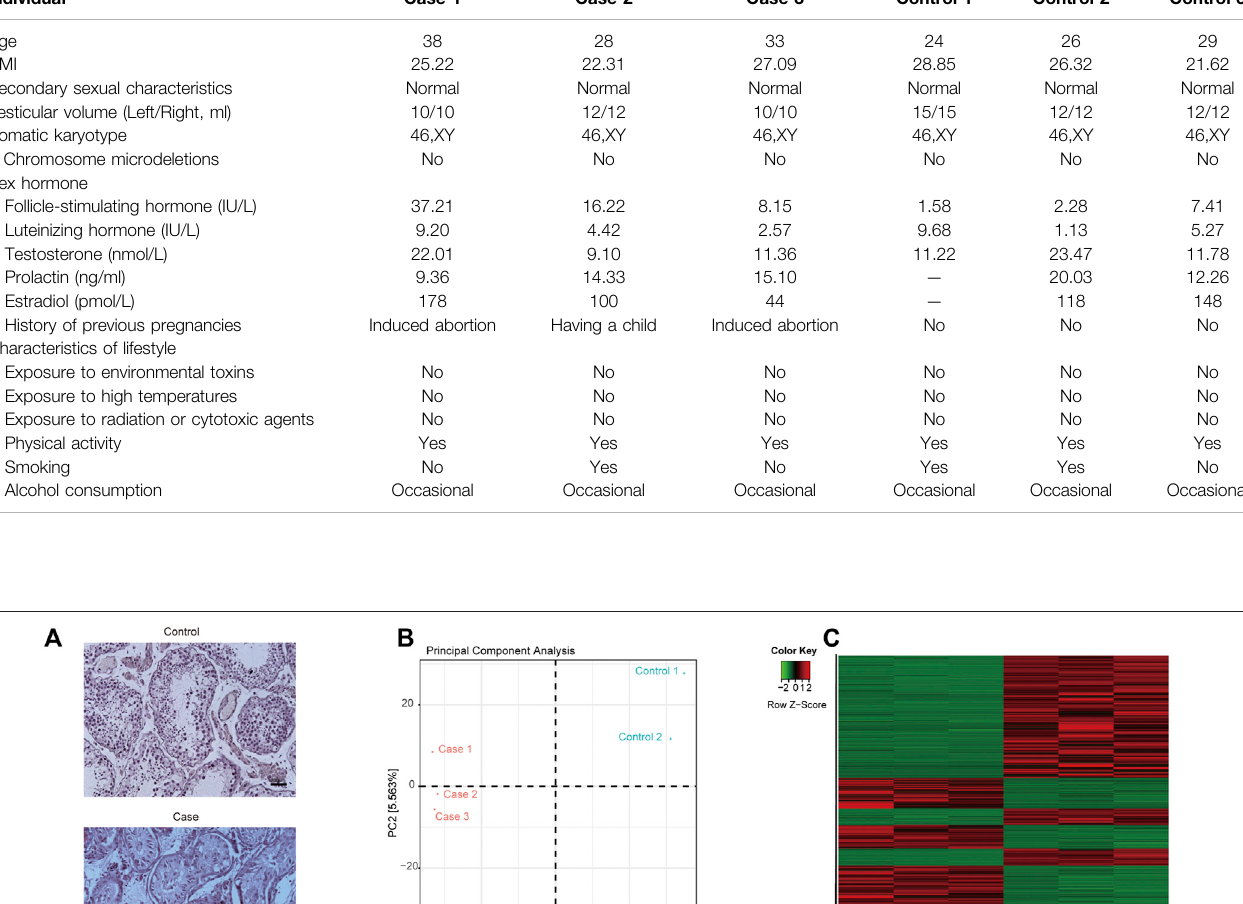
TABLE 1 | Clinical features of cases with secondary iNOA and controls. Individual